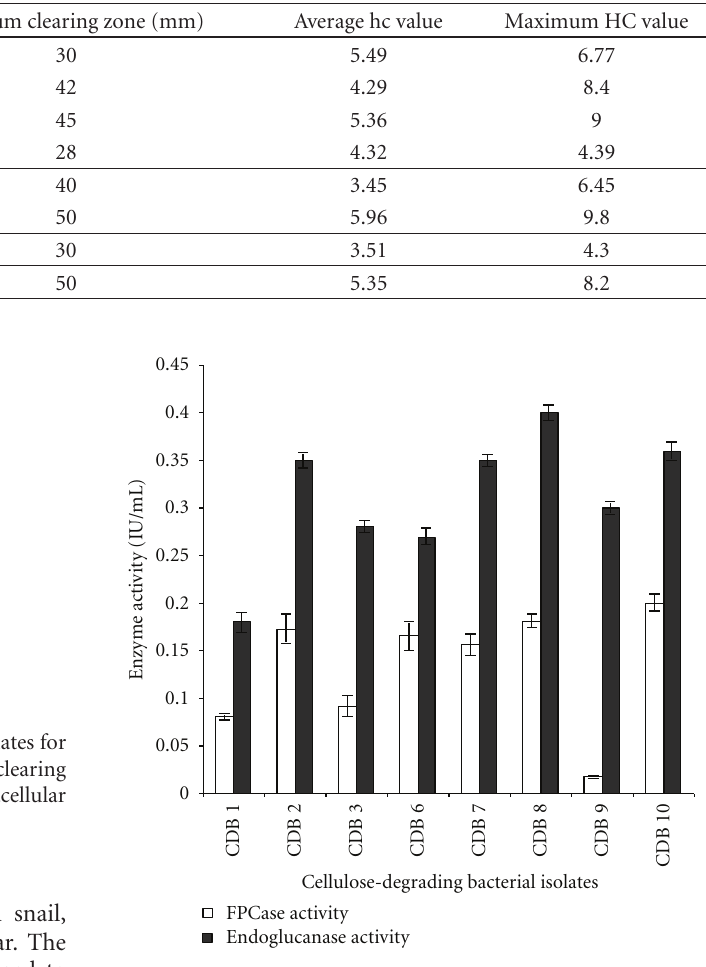
Figure 2: Extracellular cellulase activity of two enzymes (FPCase and endoglucanase) of all CDBs isolates. The activities ranged from 0.012 to 0.196 IU/mL for FPCase and 0.1622 to 0.400 IU/mL for endoglucanase assay. Values in figure are means of three replicates with standard